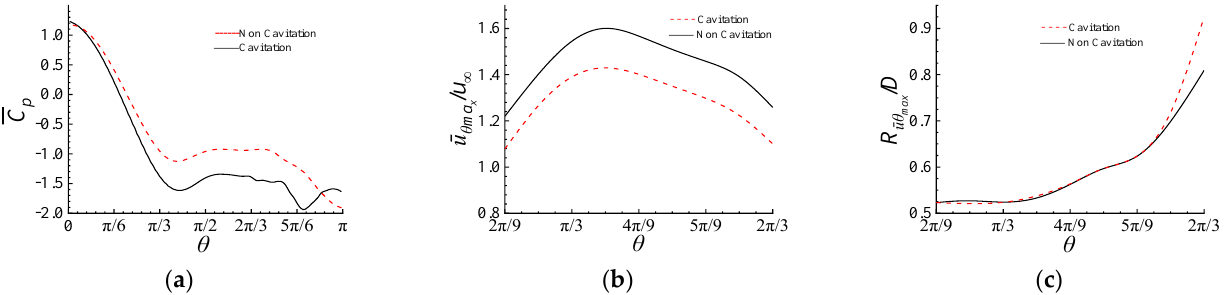
Figure 9. Pressure and velocity distributions around the cylindrical surface: ( a ) Time-averaged pressure coefficient; ( b ) Time-averaged tangential velocity; ( c ) Location of maximum time-averaged tangential velocity.